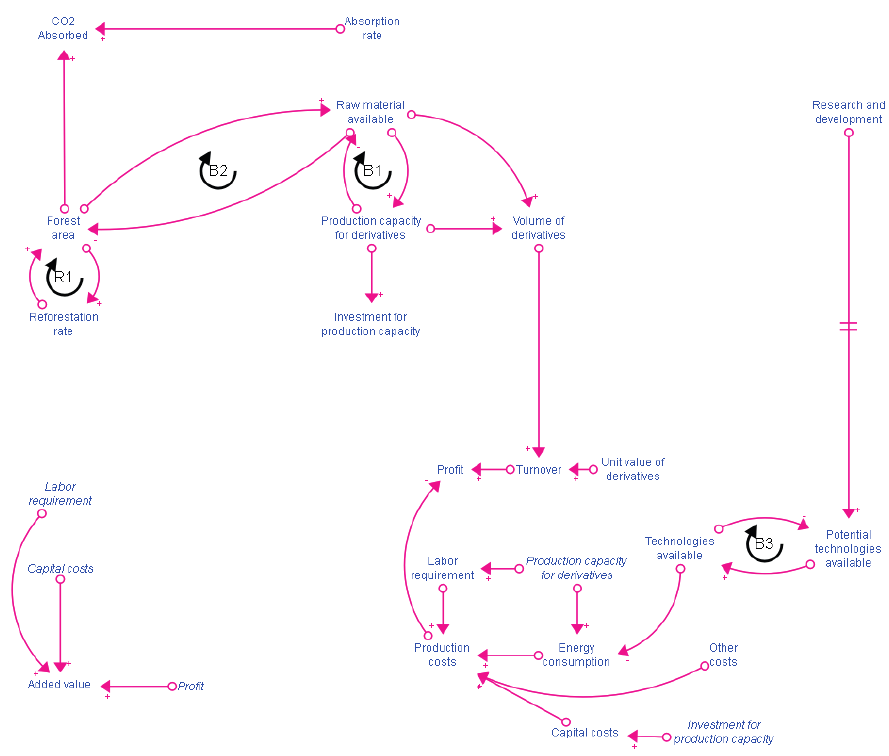
Fig. 3. Forestry causal loop